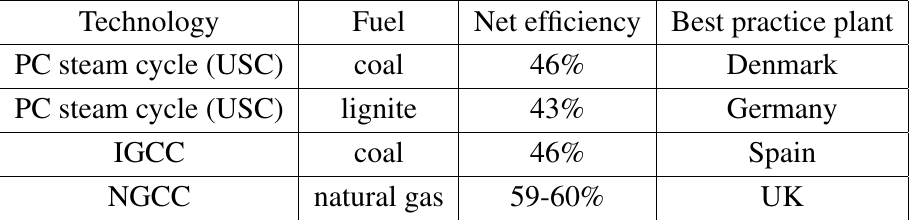
Table 6. Energy efficiency of several state-of-the-art power